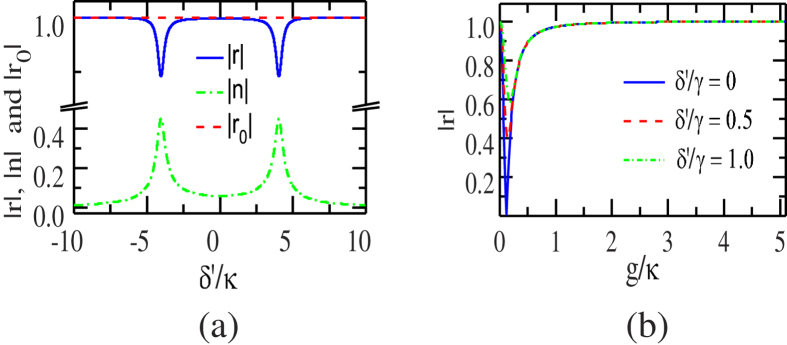
(a) |r| |n| and |r0| vs the scaled detuning δ′/κ, with the scaled coupling rate53
g/κ = 4.0566 and γ/κ = 0.0566. (b) |r| vs the scaled coupling rate g/κ with detuning δ′/γ = 0, 0.5, and 1.